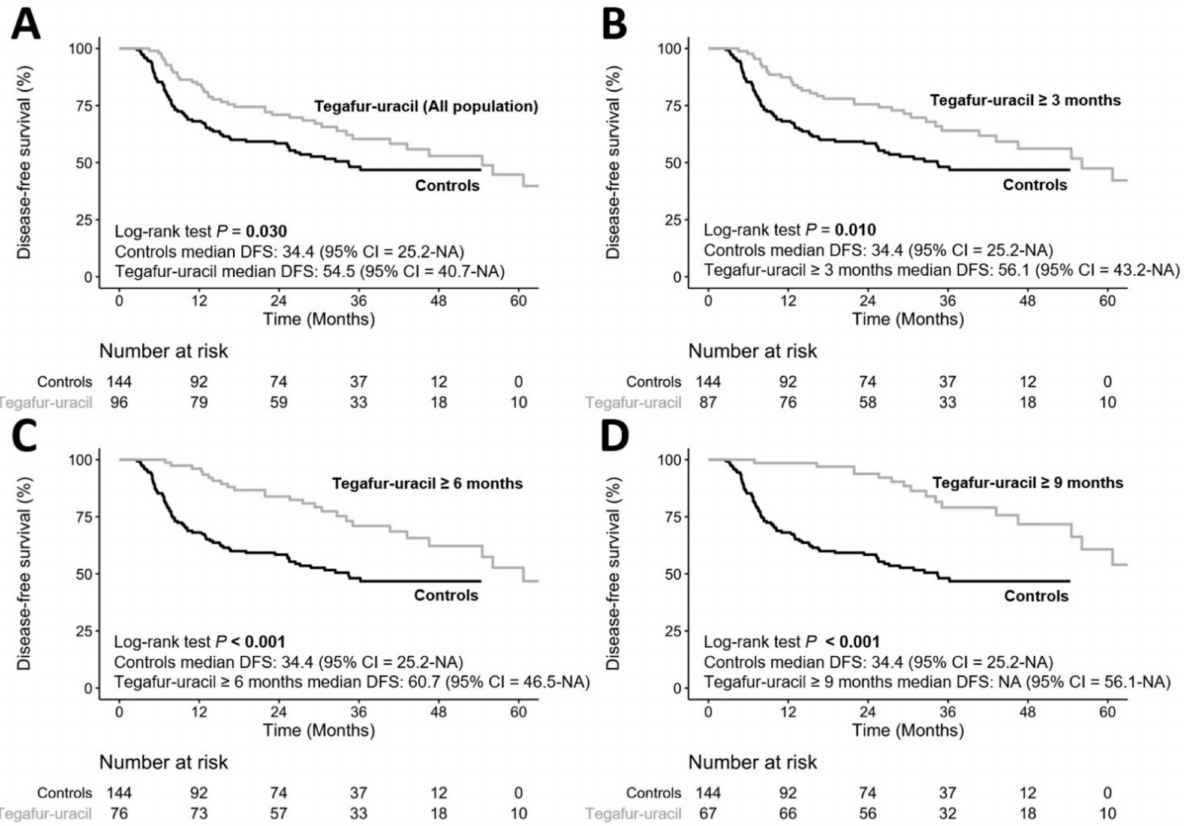
Figure 2. Comparison of tegafur–uracil duration on disease-free survival. ( A ) all population using tegafur–uracil vs controls, ( B ) tegafur–uracil ≥ 3months vs controls, ( C ) tegafur–uracil ≥ 6 months vs controls and ( D ) tegafur–uracil ≥ 9 months vs